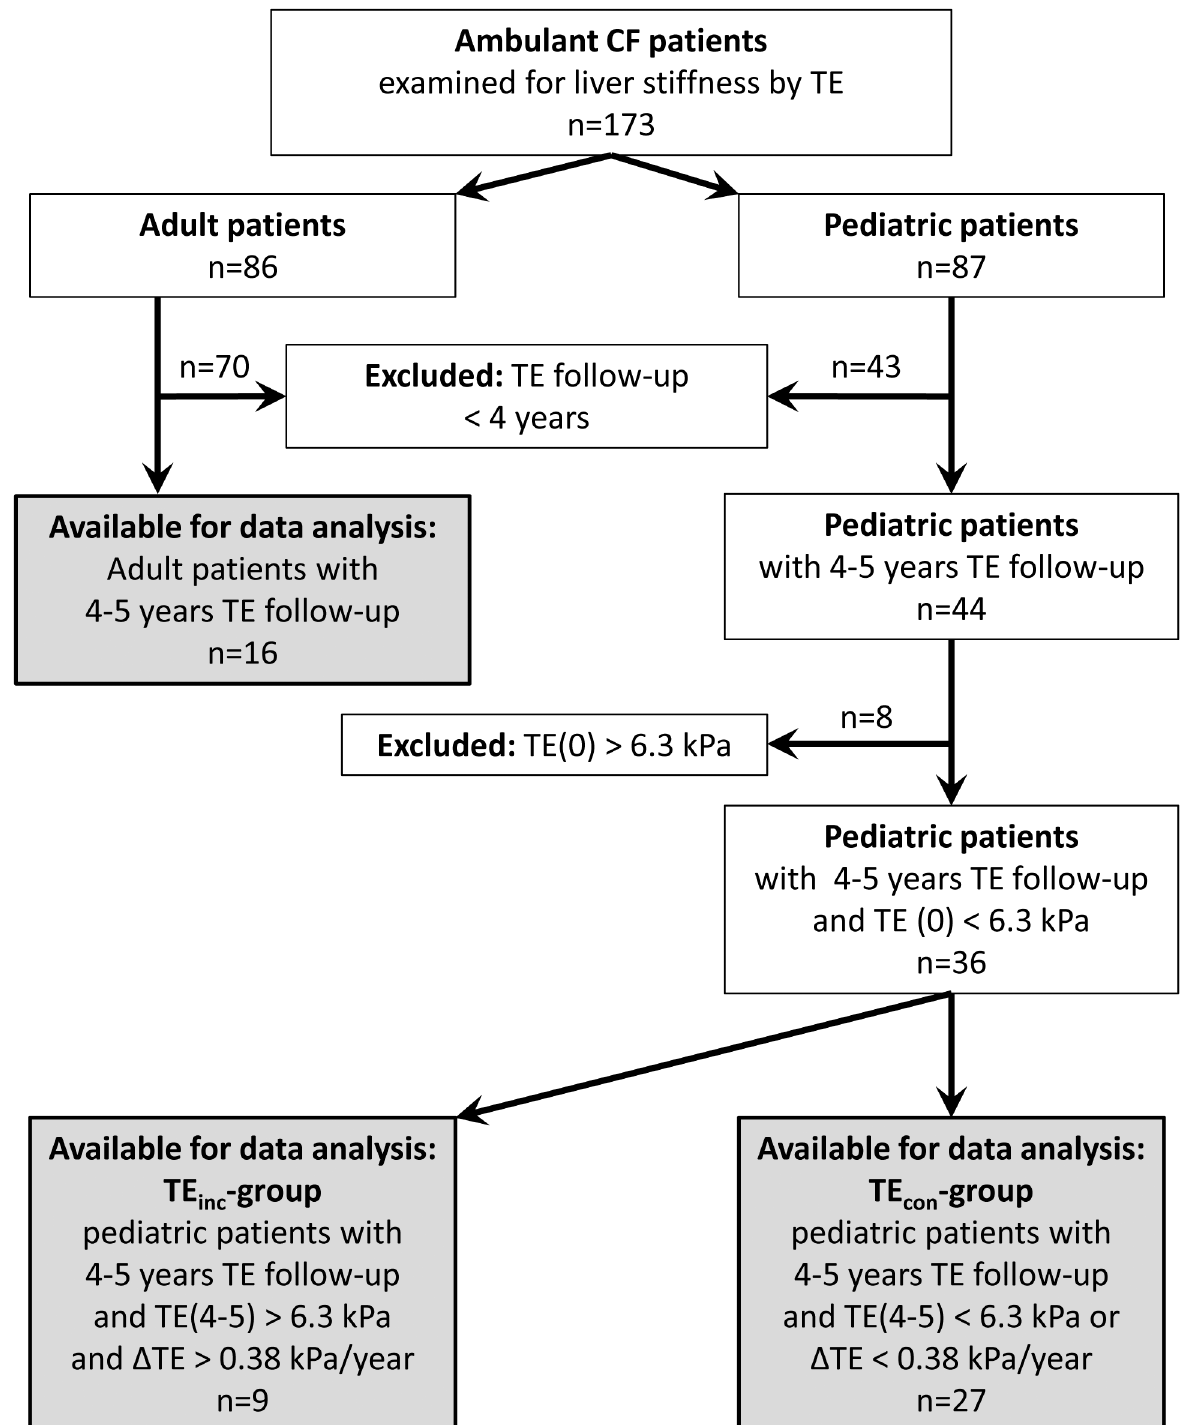
Fig 1. Derivation of study cohort. TE = Transient elastography.